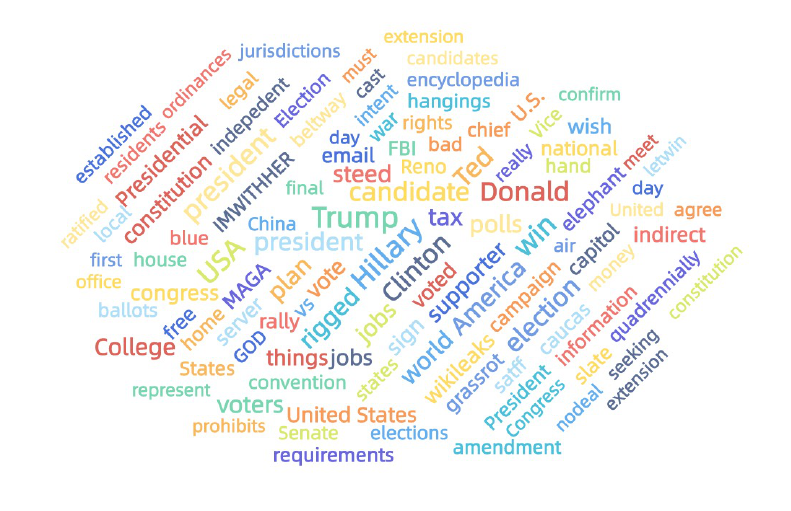
Figure 6. Topic word cloud of ELECTION